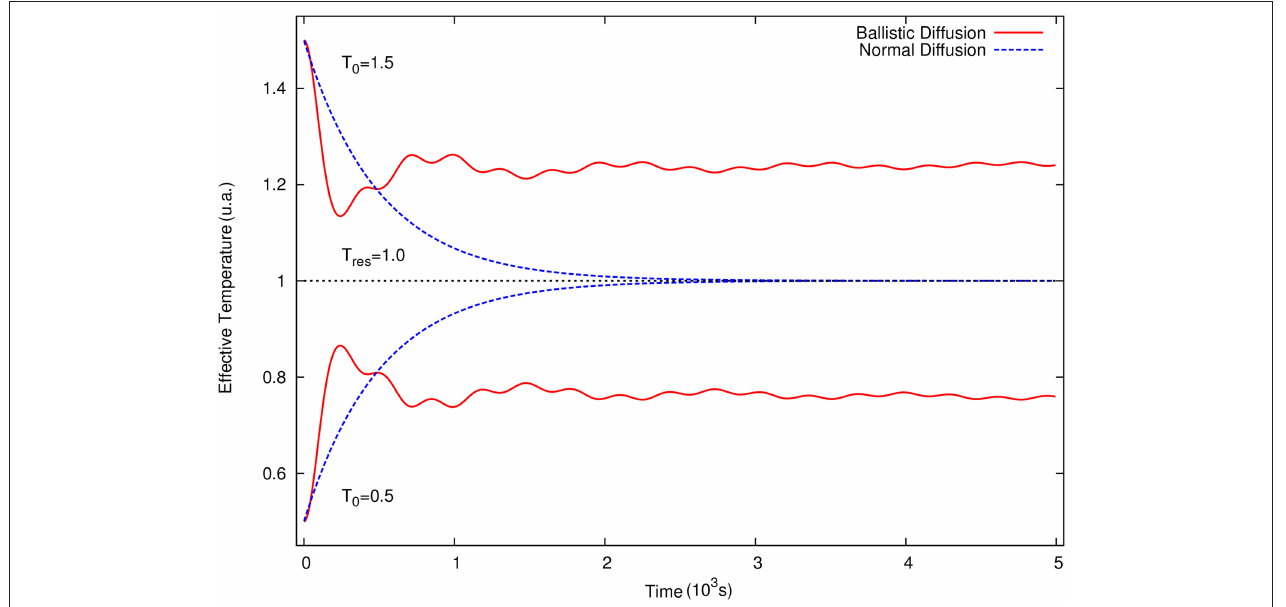
FIGURE 5 | (Color ) Time evolution of the effective kinetic temperature (in arbitrary units) for normal and ballistic diffusion. For BD we use the noise distribution ρ ( ω ) 2 γ/π for 1 < ω < 4 and ρ ( ω ) 0, otherwise, and we found R ( t ) numerically (solid curve). Since BD converges very slowly, we use γ = = exp ( γ t ), so we can compare both. We choose T 0 for normal diffusion with R ( t ) = − the reservoir temperature. From Lapas et al. [83], with permission from Europhysics